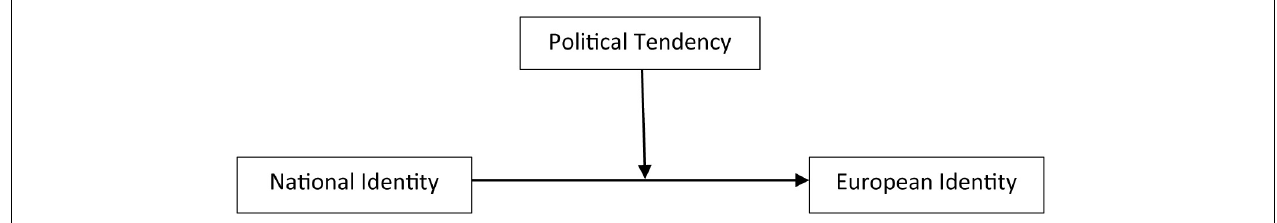
FIGURE 1 | Moderation model, taking National Identity as predictor, European Identity as dependent variable and Political tendencies as moderator.